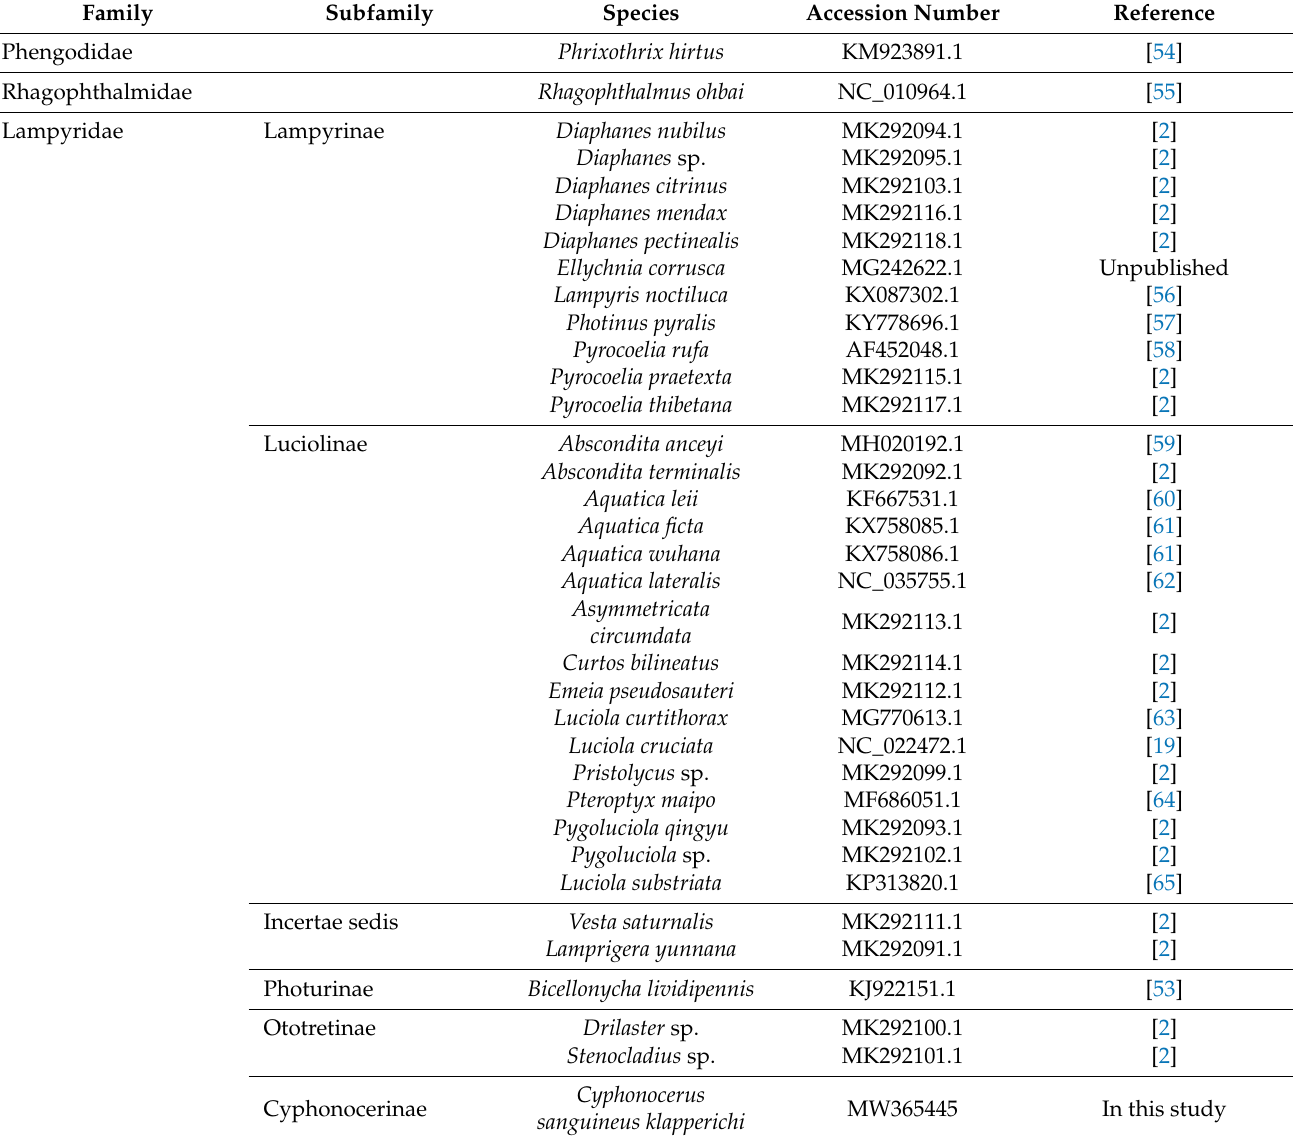
tary Table S4), or by MrBayes 3.2.6 [52] (for the PCGRNA matrix) with two independent Markov Chain Monte Carlo chains run of 2 × 10 6 generations, of which the tree was sampled every 1000 generations, and the initial 25% of sampled data were discarded as burn. ITOL (http://itol.embl.de/, accessed on 10 April 2021) [53] was used to annotate and beautify the phylogenetic tree. Table 1. Information for the representative species’ mitogenomes used for phylogenetic analysis.